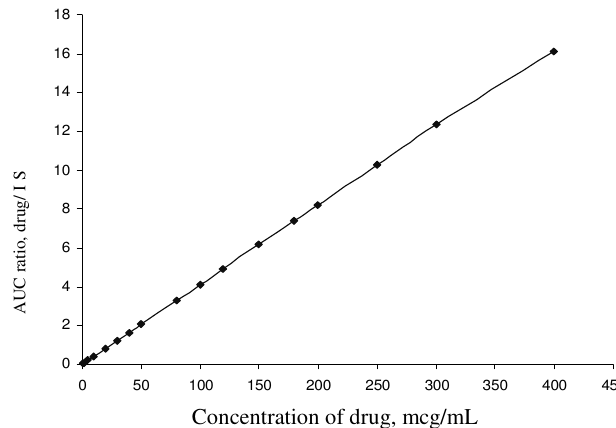
Figure 2. Calibration curve of nebivolol by